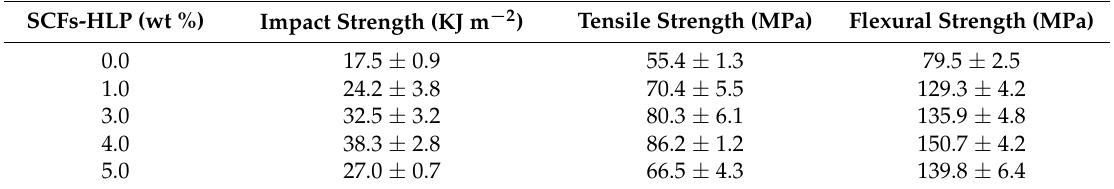
Figure 8. ( a ) Stress-strain curves of EP and SCFs-HLP/EP composites; ( b) impact strength of EP and SCFs-HLP/EP composites; and ( c ) flexural strength and tensile strength of EP and SCFs-HLP/EP composites. Table 1. Mechanical properties of EP and its composites.